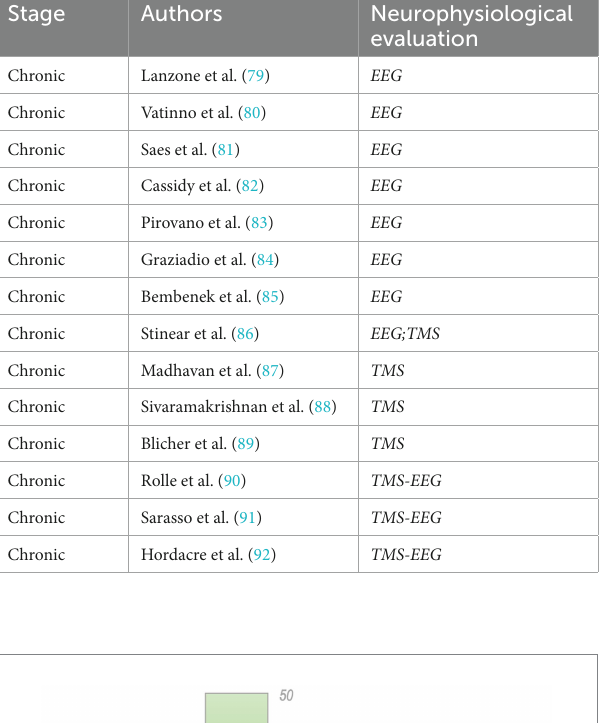
TABLE 1 Overview of the reviewed